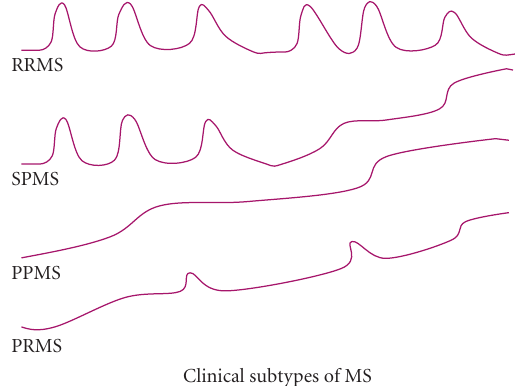
Figure 3: The four common clinical subtypes of MS are illustrated. RRMS (Relapsing-remitting MS). At least one clinical attack resulting from demyelination (relapsing phase) follows by complete or partial recovery (remitting phase), after the first recovery from an attack. SPMS (Secondary progressive MS). Symptoms are continuously and gradually worsening, after a period of RRMS. PPMS (Primary progressive MS). Symptoms keep worsening after the onset, without obvious relapsing-remitting phases. PRMS (Progressive relapsing MS). MS with characteristics of both PPMS and